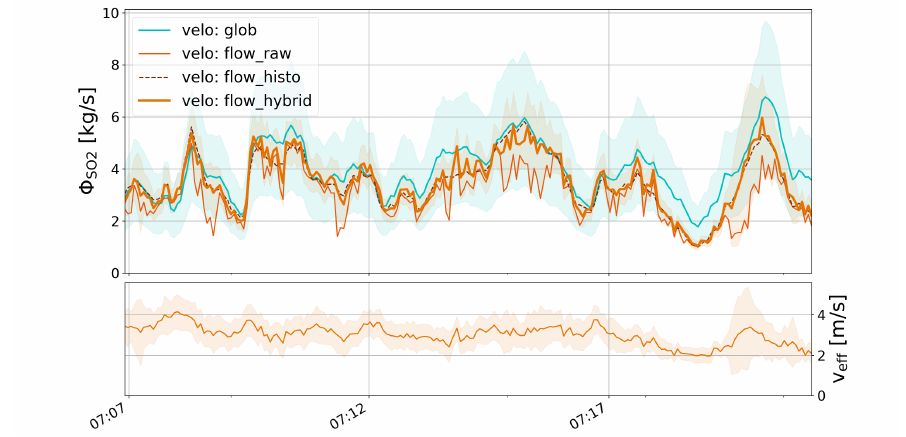
Figure 11. Emission rate retrieval. Emission rates (top) and plume velocities (bottom) of the Etna example dataset on 16 September 2015 between 7:06 a.m. and 7:22 a.m. UTC using the retrieval line “PCS” shown in Figure 8. The analysis was performed using (1) a global velocity of 3.5m/s (cyan, from cross-correlation analysis); (2) the raw output of the Farnebäck algorithm (thin orange); (3) using the flow_histo method (thin dashed brown) and (4) using the flow_hybrid method (bold orange). The retrieved effective velocities are plotted in the lower panel and correspond to the average velocities along the PCS line using the flow_hybrid method. Uncertainties are displayed as shaded